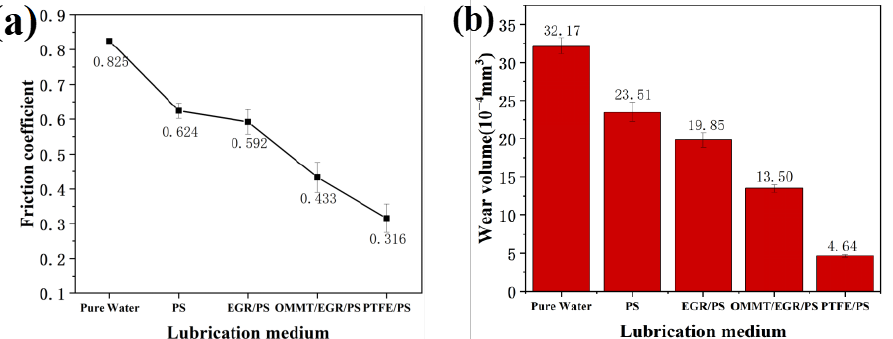
Figure 6. ( a ) The friction coefficient and ( b ) wear volumes of composite microspheres.